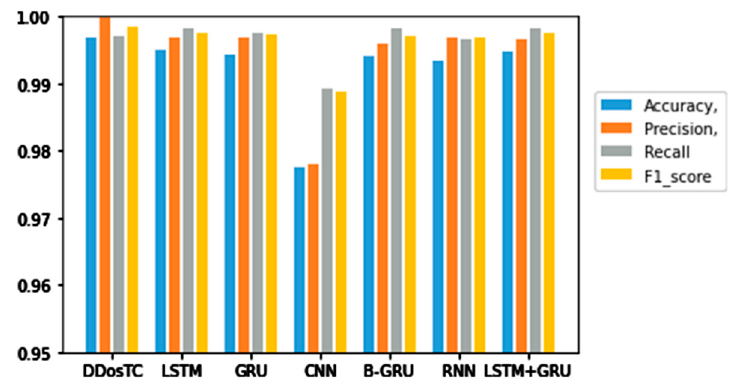
Figure 10. Accuracy, precision, recall rate, and F1 score results for DDosTC and other test methods with a training set/test set ratio of 7:3.